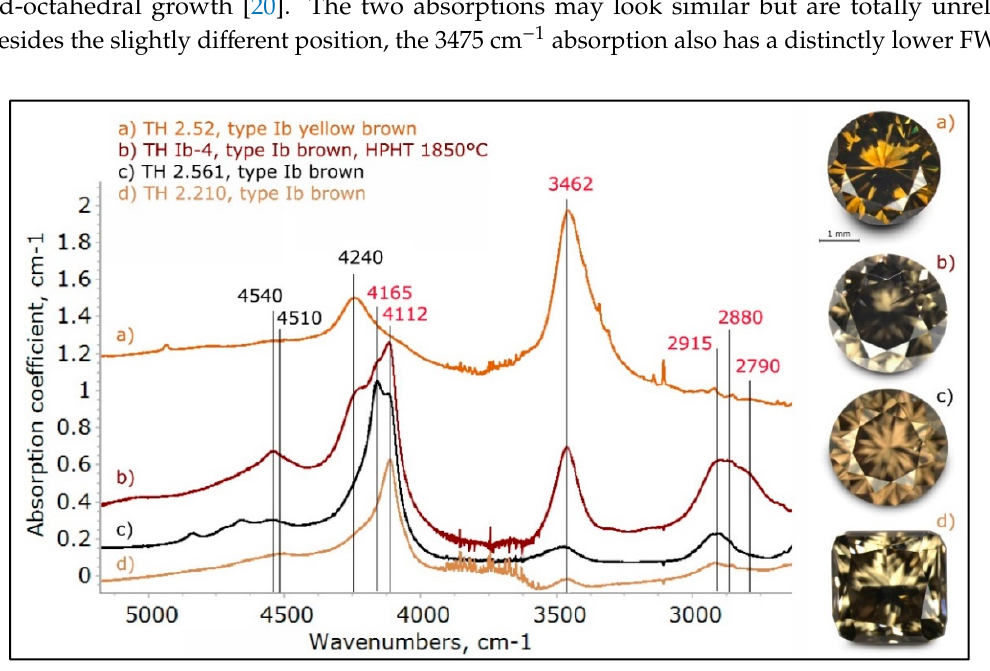
Figure 7. The normalized near infrared spectra of type Ib DR brown diamonds after subtraction of the intrinsic diamond absorptions. All of the spectra show the 3462 cm − 1 AC ZPL and its likely vibronic component at 4240 cm − 1 ; this graph demonstrates that the bands between 2915 and 2790 cm − 1 do not relate to the 3462 cm − 1 absorption. Instead, it is indicated that these bands are additional ACs, and that the bands at 4540 and 4510 cm − 1 are likely vibronic components of these ACs. The spectra were shifted vertically for clarity.